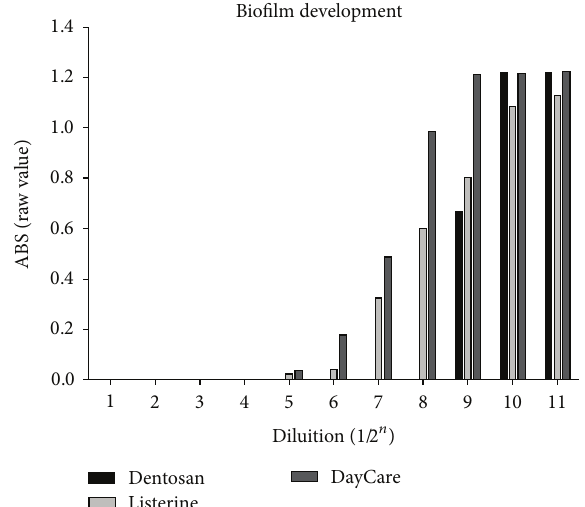
Figure 2: Comparison between absolute values of absorbance related to the BD of Aa when exposed to growing dilution (from 1/2 to 1/2048) of the tested